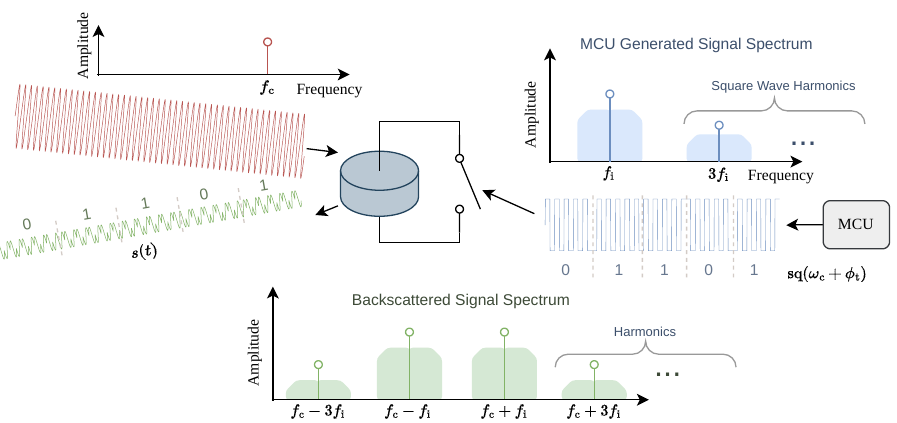
Figure 5. At the tag, the incoming sine carrier wave is modulated with a PSK-modulated square wave at an intermediate frequency from the MCU. While the square wave has infinite bandwidth, the reflected signal also has infinite